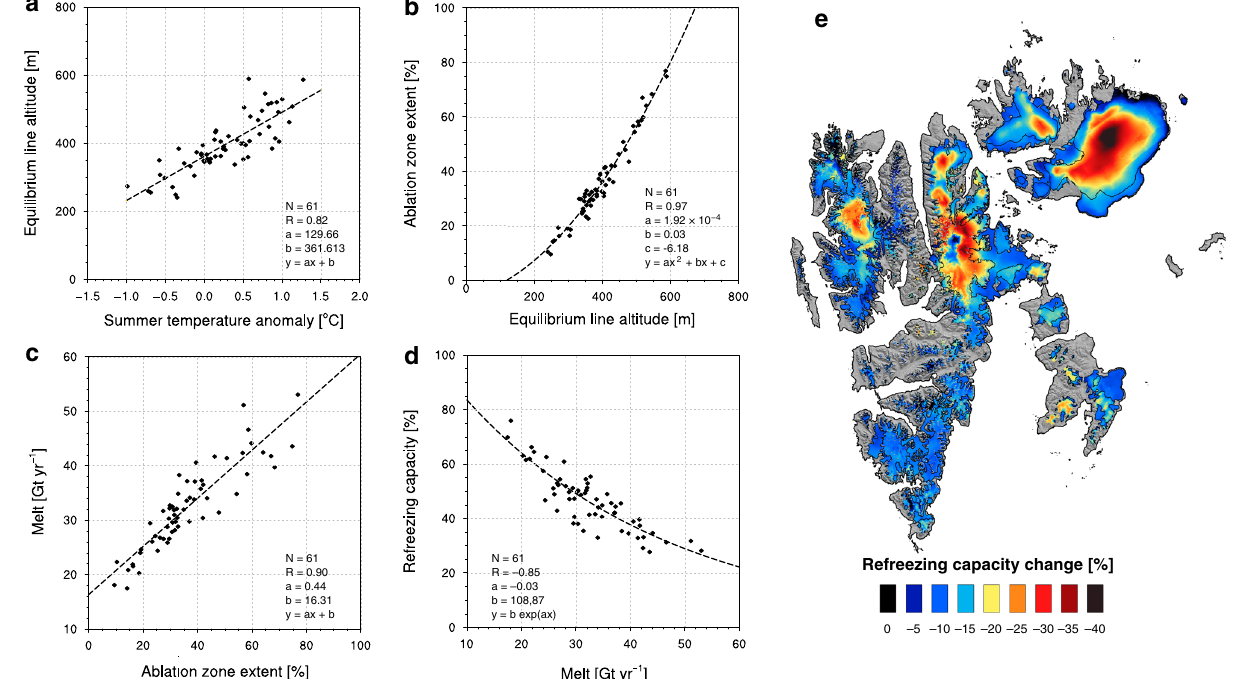
Fig. 4 Sensitivity of Svalbard refreezing capacity to atmospheric warming. Scatter plots showing Svalbard-wide correlations between a June – July – August 2 m air temperature anomaly (1985 – 2018 minus 1958 – 1984) and ELA. b ELA and ablation zone area, c ablation zone area and surface melt, and d melt and fi rn refreezing capacity. Statistics include number of records ( N ), correlation ( R ), and fi tting parameters ( a – c ). e Post-1985 change in refreezing capacity (%; 1985 – 2018 minus 1958 – 1984). ELA for the period 1985 – 2018 is also shown as a black